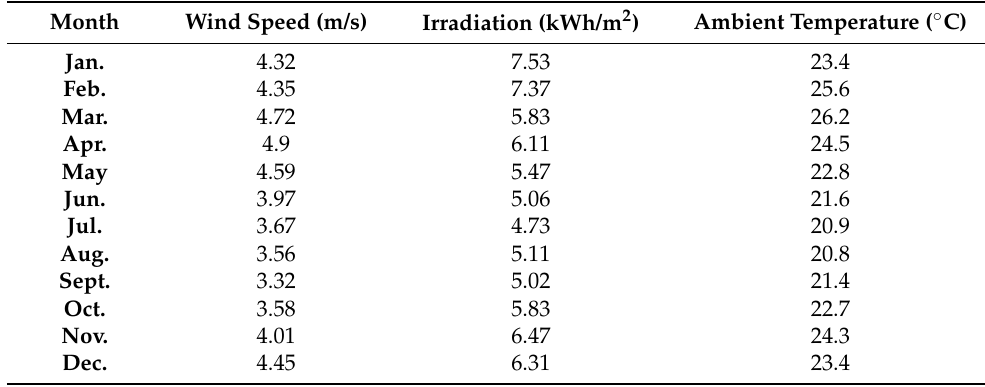
Figure 3. Monthly hourly irradiance data over one year [33]. Table 2. Average monthly data of irradiation, ambient temperature, and wind speed (50 m height) of the study site